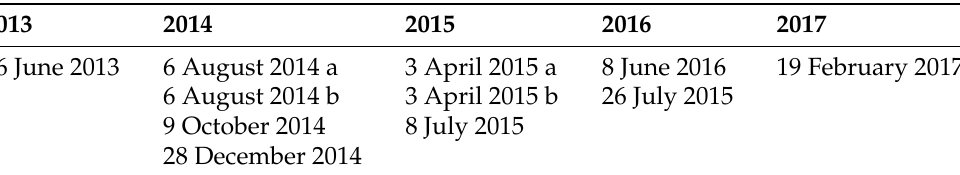
Figure 2. Location of the study area and the distribution of soil samples. Table 1. Landsat-8 image acquisition